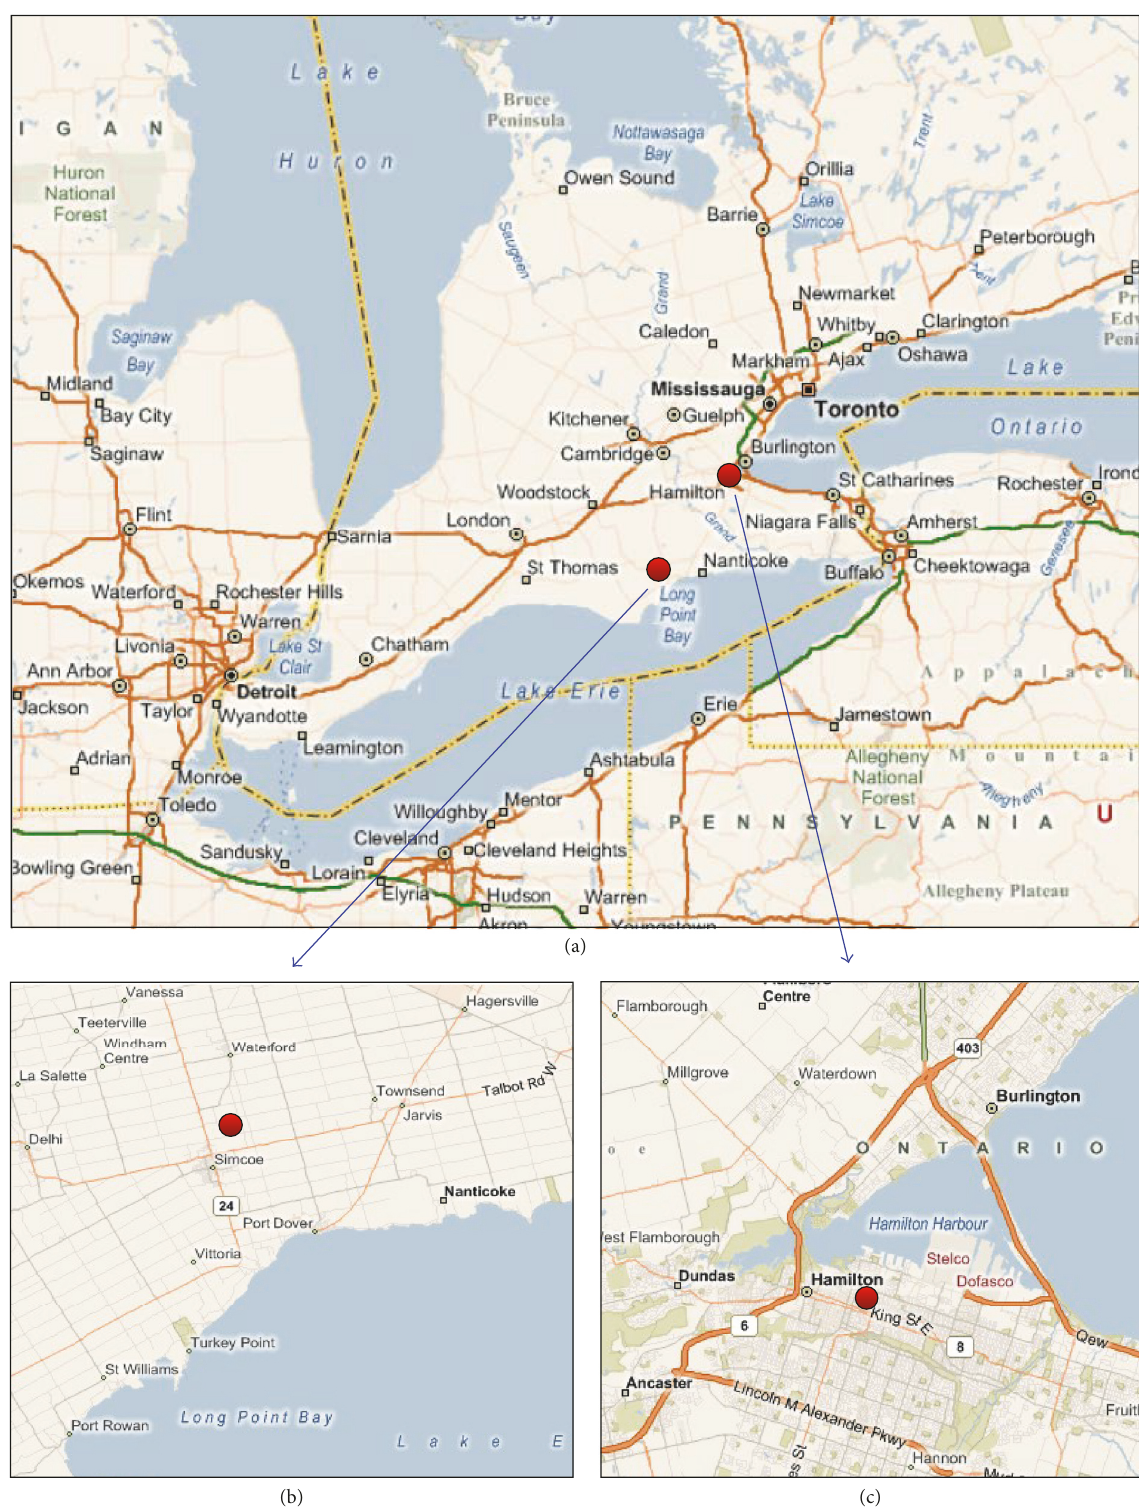
Figure 1: Location of sampling stations for the SONTAS 2000: southern Ontario (a), Simcoe (b), and Hamilton (c). Source :